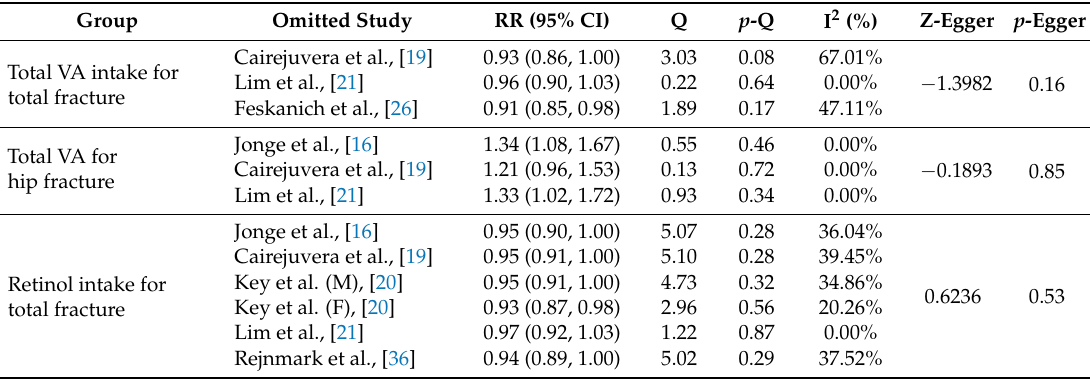
Table 4. Sensitivity analyses and publication